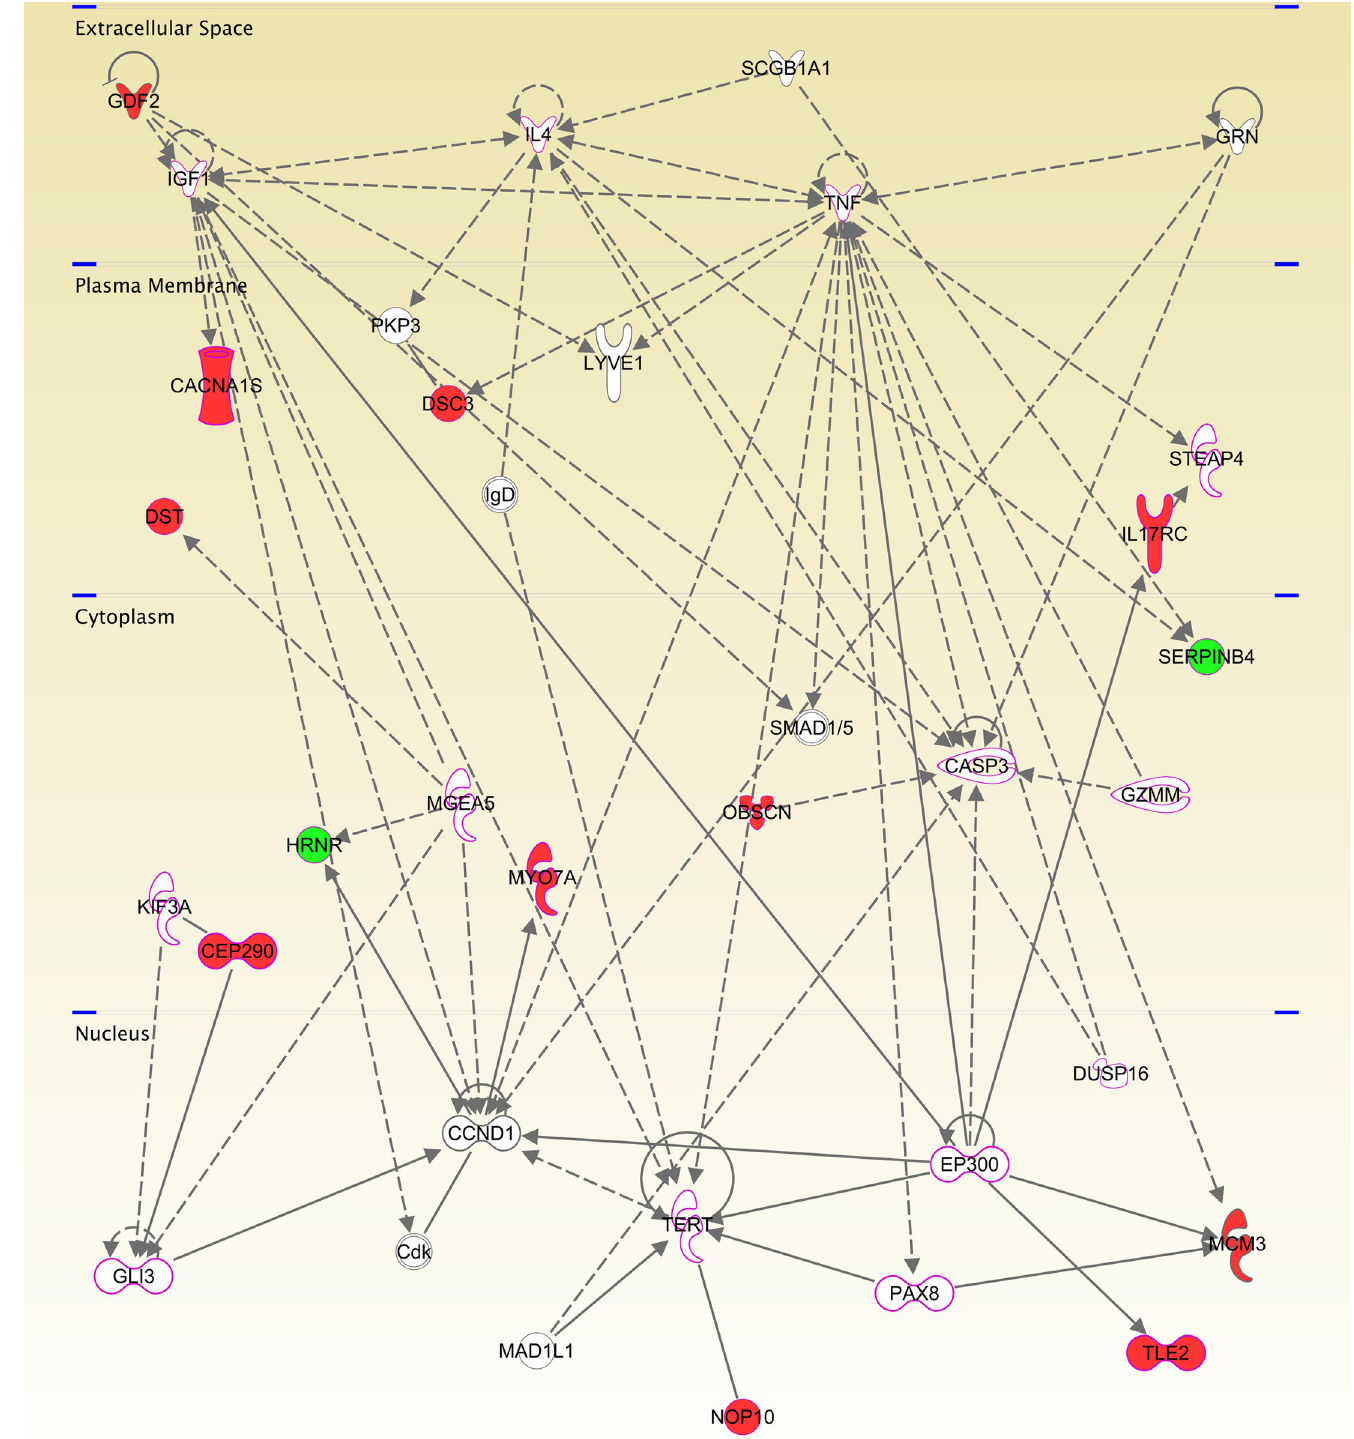
Fig 3. Network of 13 genes harboring rare germline variants identified in melanoma-prone patients. Network generated by the IPA software displaying interactions between 13 genes identified by exome sequencing and 22 other genes automatically included after they were identified as biologically connected based on scientific evidence. The functional categorization of this network was cancer, dermatological diseases, and organismal injuries and abnormalities. The red nodes represent genes identified by this study harboring missense variants; the green nodes represent genes identified harboring LoF variants; the white node genes were plotted by the software once they are associated by scientific evidence. The nodes highlighted in pink represent genes involved in melanoma tumorigenesis according to IPA.